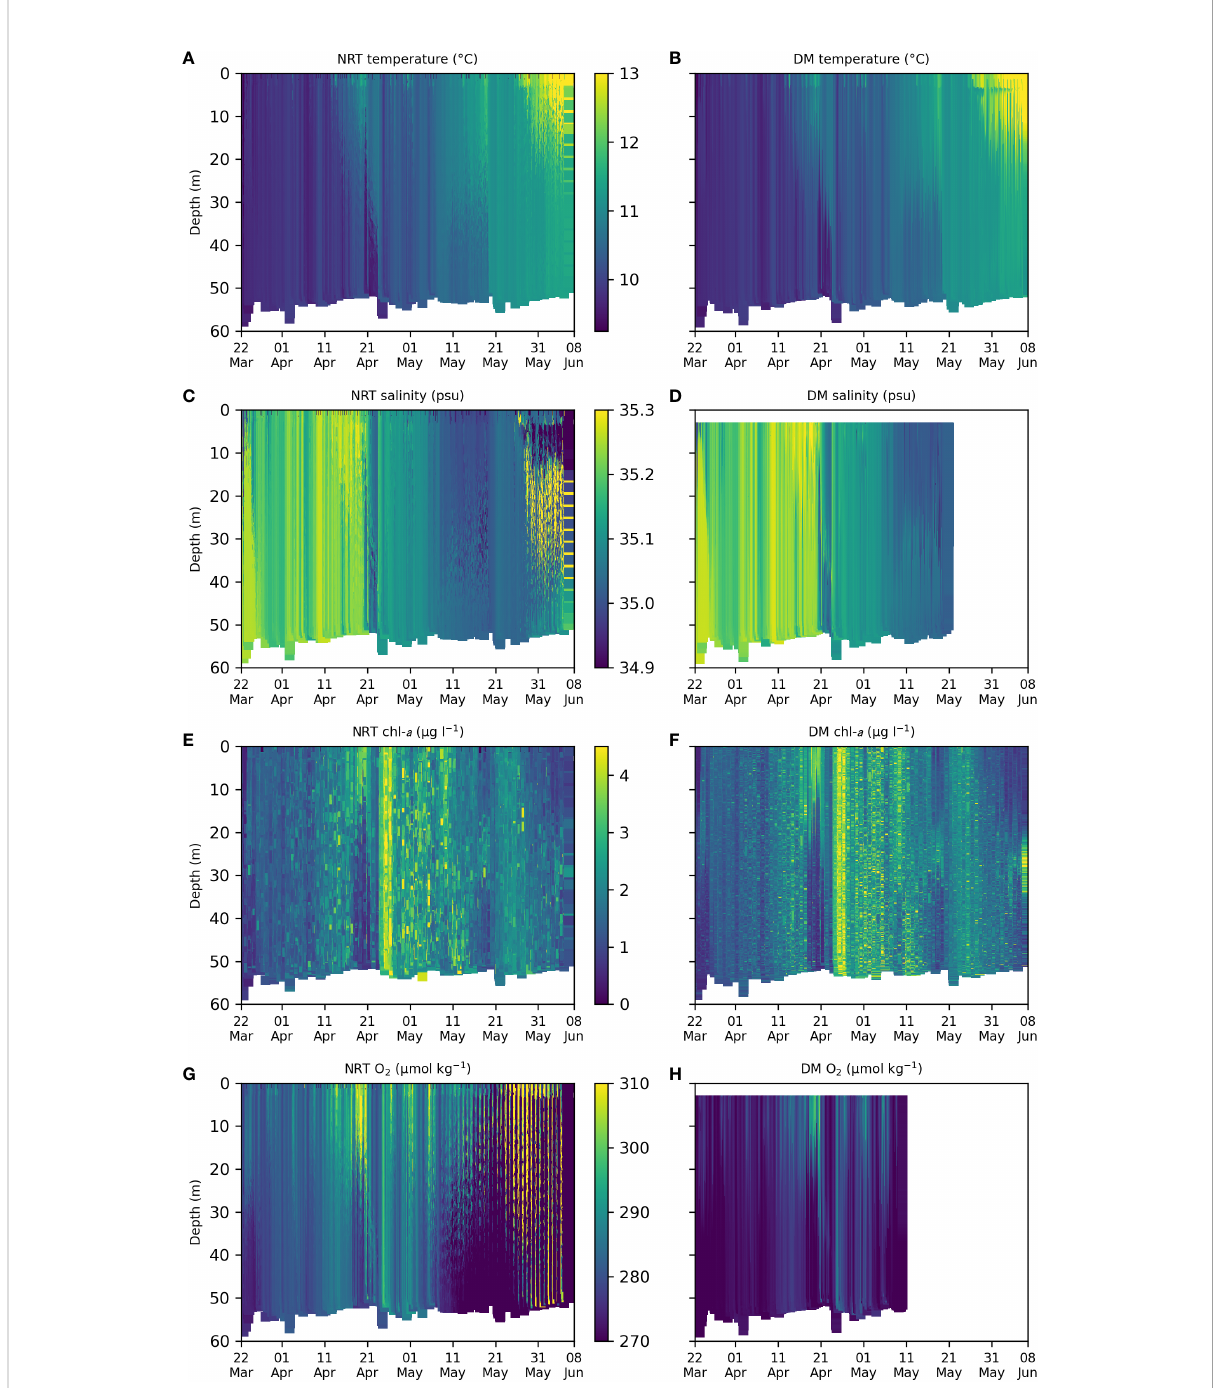
FIGURE 4 Plots along the glider transect for different variables, from the NRT glider data (left column) and DM quality-controlled glider data (right column). (A) NRT temperature, (B) DM temperature, (C) NRT salinity, (D) DM salinity, (E) NRT chl- a , (F) DM chl- a , (G) NRT O 2 , (H) DM O 2